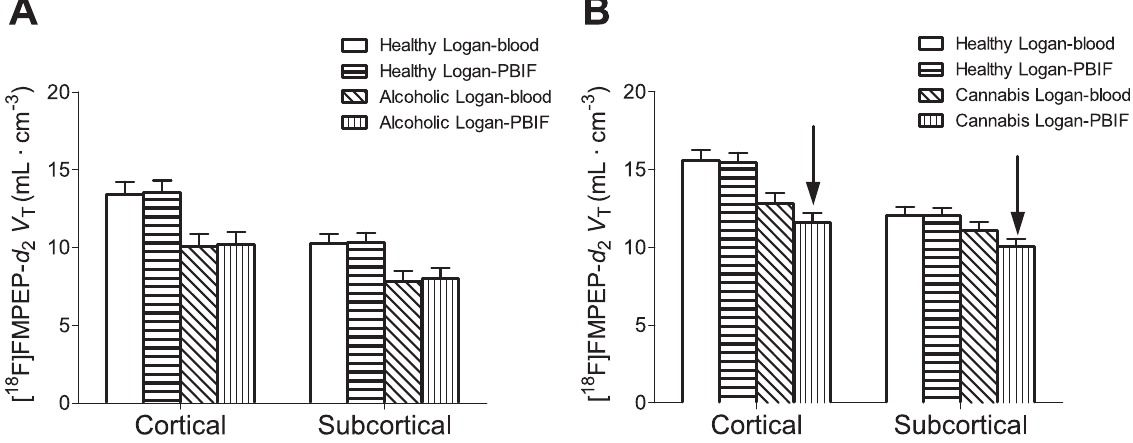
Figure 2. Comparison of Logan- V T results in cortical and subcortical regions for healthy volunteers, alcoholic subjects and cannabis smokers, obtained with full input and the PBIF. Results at baseline in alcoholic subjects (A) and cannabis smokers (B), compared to healthy controls for both full input and PBIF. PBIF provided accurate Logan- V T values in healthy subjects and alcoholic patients and closely replicated previous findings of widespread downregulation. In cannabis smokers, PBIF underestimated Logan- V T (arrows); the results suggest the